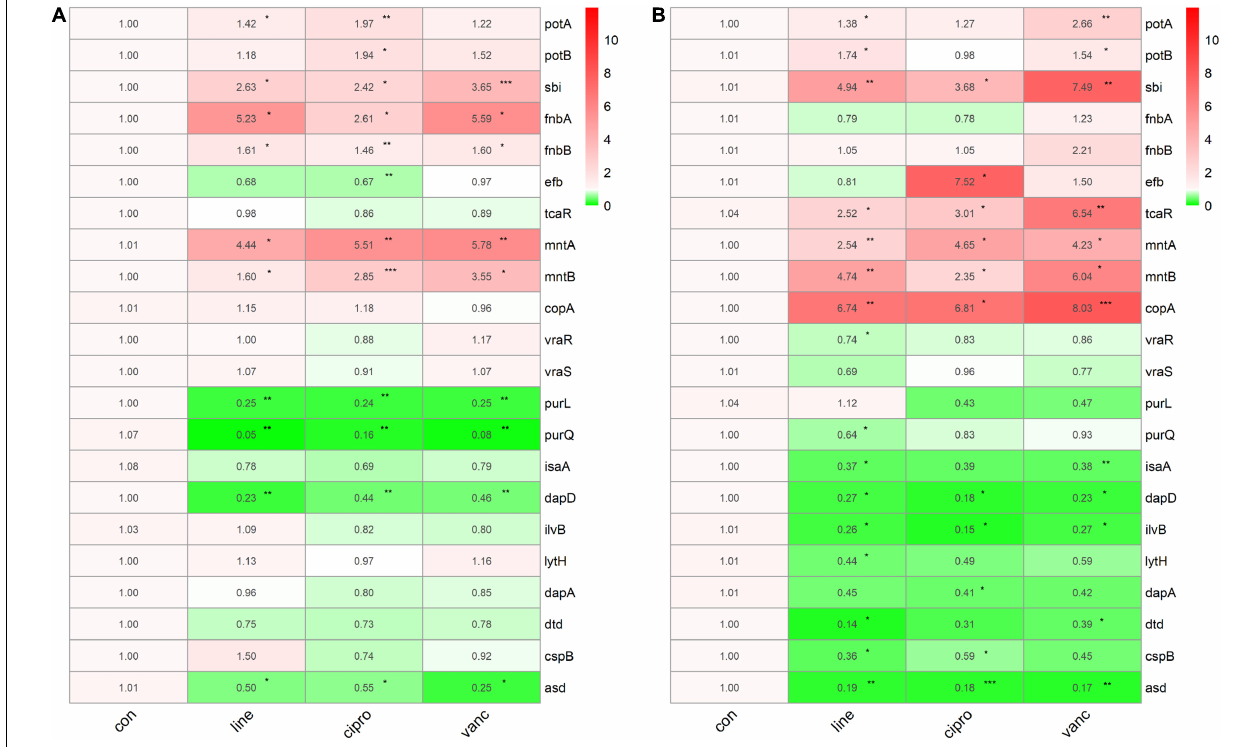
Frontiers in Microbiology |